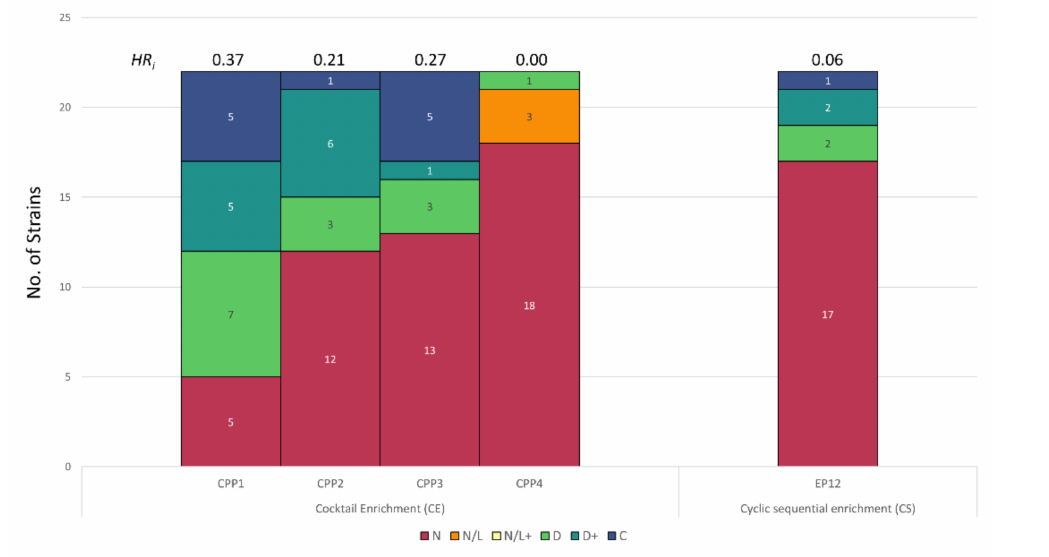
Figure 7. Stacked bar plot showing the host range of phages infecting Pseudomonas environmental strains isolated using different enrichment methods. Designation: C, complete inhibition, D+, >5 h delay to reach exponential phase; D, <5 h delay to reach exponential phase; N, no effect; HR i , host range